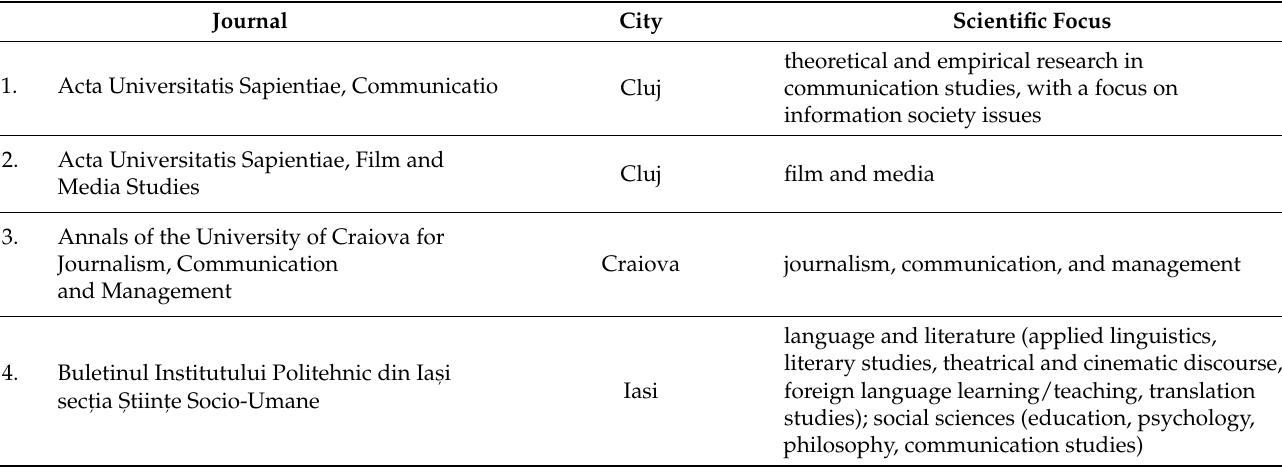
Table 1. List of Romanian communication sciences journals by city and scientific